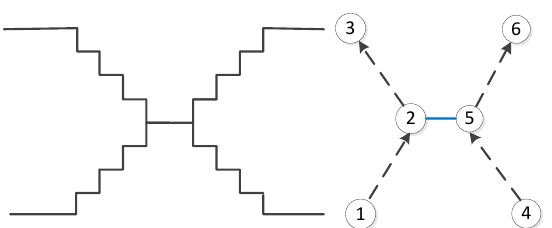
Figure 7. An example of using OSM ways and OSM relations to model stairs. The stairs here are split into three parts: (1) a relation with members Step 1, Step 2 and Step 3; (2) a relation with members